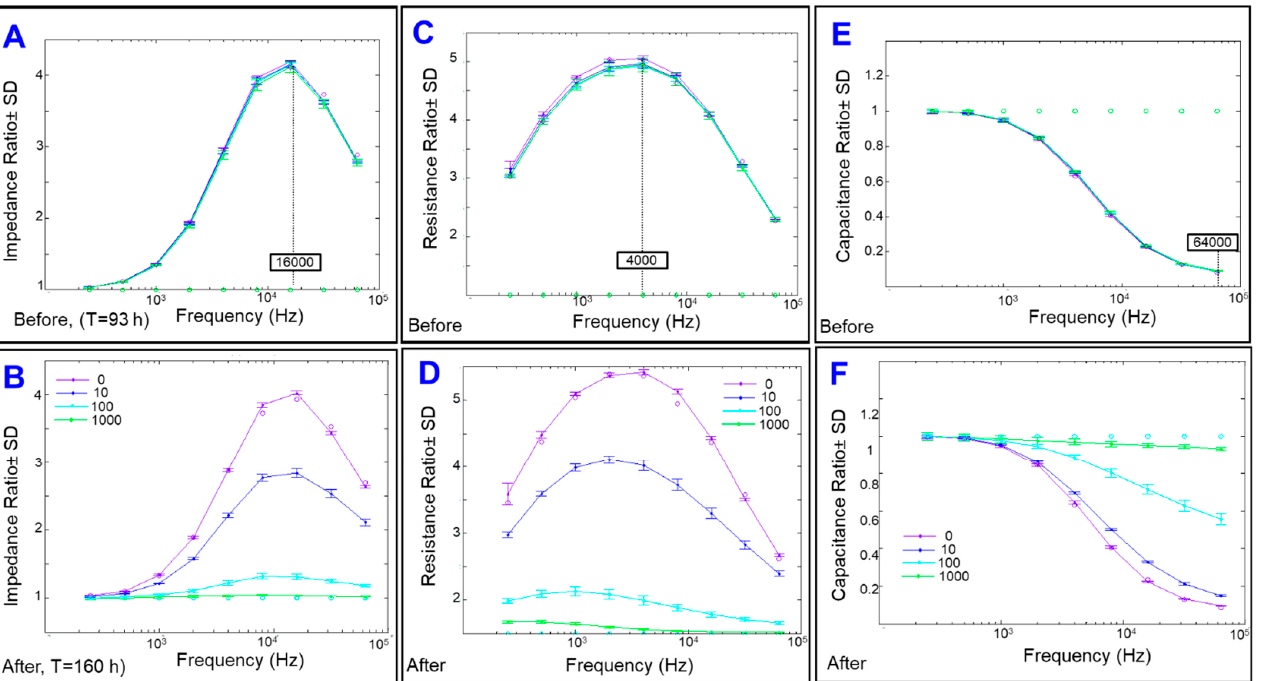
Figure 2. Separation of the impedance into resistance and capacitance. ( A ) Impedance Ratio to the cell-free medium vs. Frequency (Hz) measured at 93 h after ARPE-19 cells placement onto electrodes with a local maximum at 16,000 Hz. ( B ) Impedance Ratio to the cell-free medium vs. Frequency (Hz) measured at 160 h after ARPE-19 cells placement onto electrodes, which is 67 h after application of treatment. ( C ) Resistance Ratio to the cell-free medium vs. Frequency (Hz) measured at 93 h after ARPE-19 cells placement onto electrodes, with a local maximum at 4000 Hz. ( D ) Resistance Ratio to the cell-free medium vs. Frequency (Hz) measured at 160 h after ARPE-19 cells placement onto electrodes. ( E ) Capacitance Ratio vs. Frequency (Hz) measured at 93 h after ARPE-19 cells placement onto electrodes, with a local minimum at 64,000 Hz. ( F ) Capacitance Ratio vs. Frequency (Hz) measured at 160 h after ARPE-19 cells placement onto